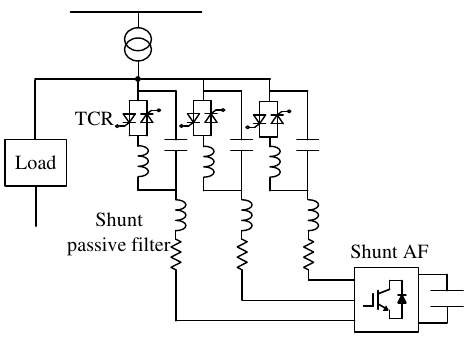
Figure 2. Power circuit diagram of the previously proposed hybrid static VAR compensator (SVC) with thyristor-controlled reactor (TCR) and phase-leading capacitor (PLC) with series AF [12,13].